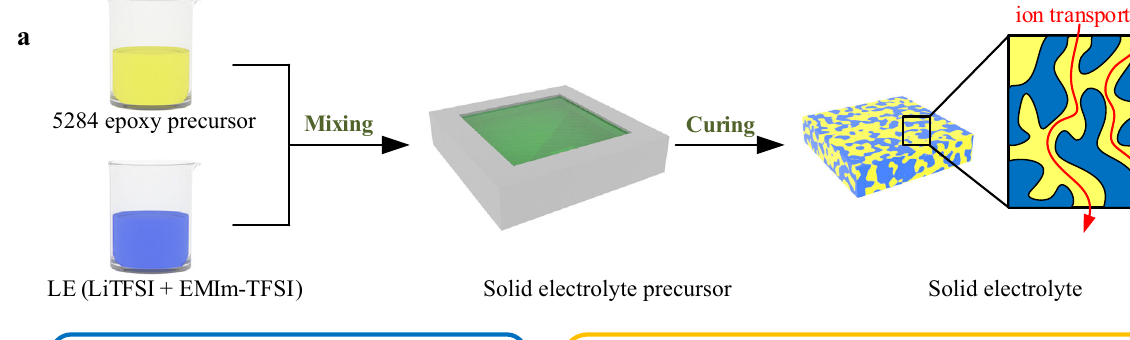
( c ) and EP 50 ( d ). e Tensile stress-strain curves of epoxy resin and different solid electrolytes. f Impedance spectra of different solid electrolytes. g The Flexural modulus (left axis) and ionic conductivity (right axis)ofdifferent samples at25°C. h Comparison of the solid electrolytes in literature with EP 50 in this